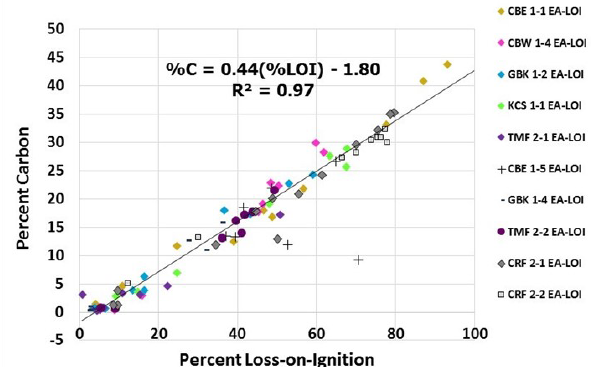
Figure A2. %LOI-to-%C relationship. Relationship between measured LOI values and calculated %C, using elemental analyzer (EA) data on set of 93 subsamples. Measurements from core CBE 1–5 were not used for calculating this relationship due to suspected measurement